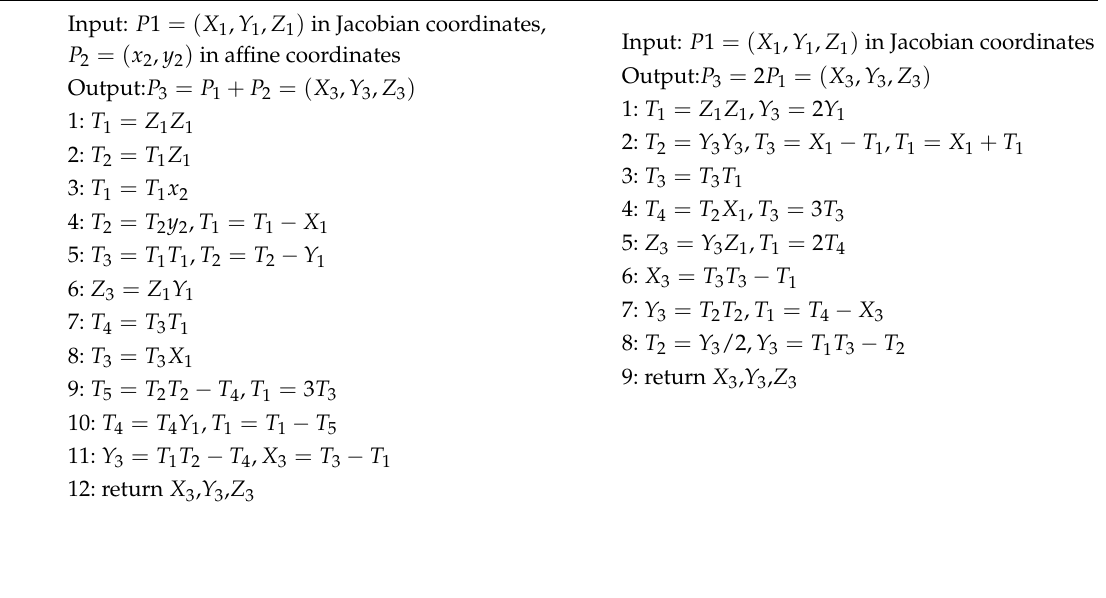
Algorithm 7: Point addition and point doubling